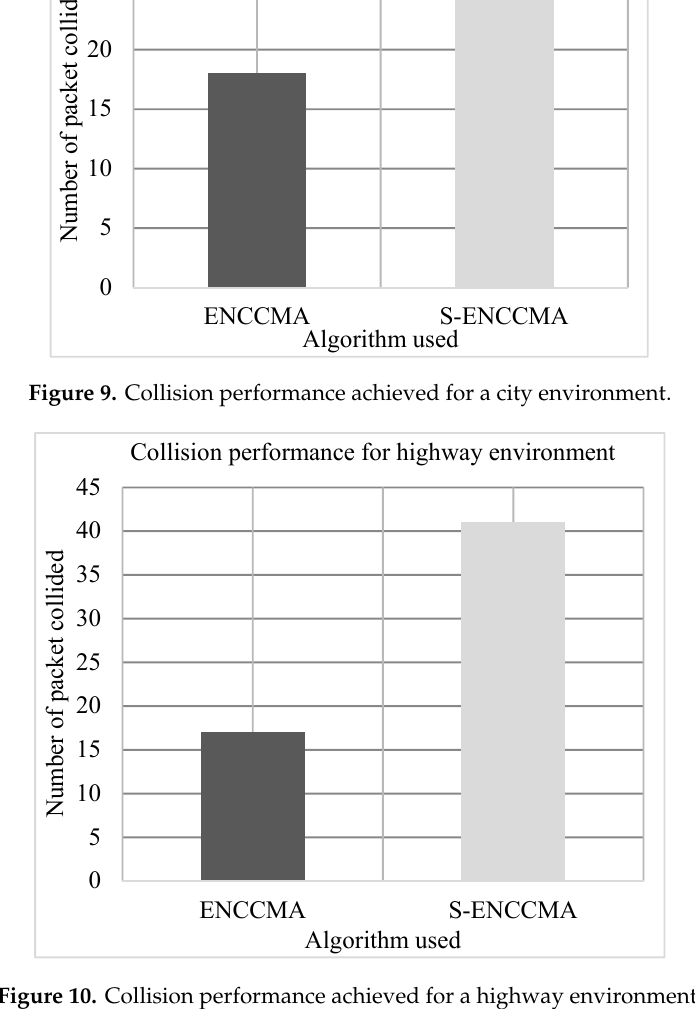
Figure 11. Collision performance achieved for a rural environment.